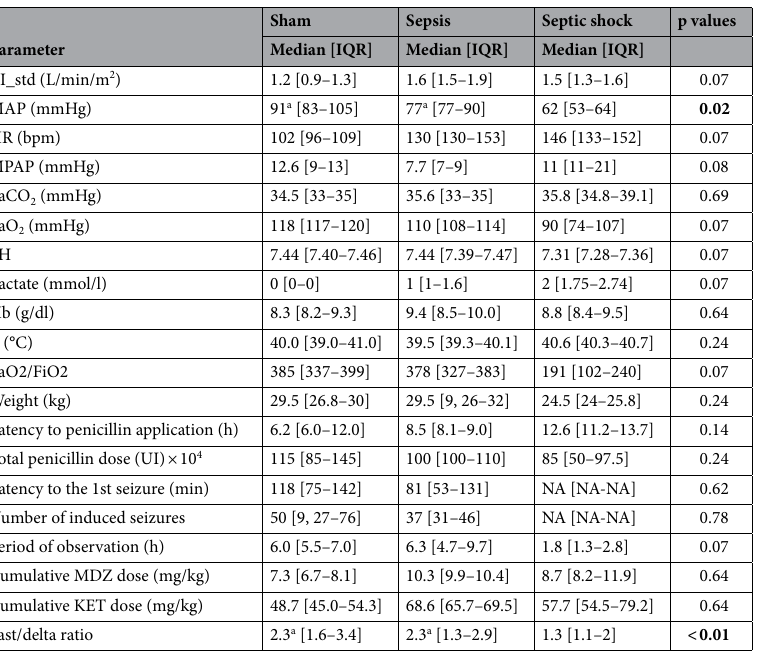
Table 1. Summary of systemic, biological parameters and information at time of penicillin application in the studied animals. Data are presented as median and (IQR). CI_std: cardiac index standardized, expressed as variation of the cardiac index of the beginning of the experiment; MAP: mean arterial pressure; HR: heart rate; MPAP, mean pulmonary arterial pressure; Hb: hemoglobin; T °C: temperature in Celsius degrees; PaO 2 / FiO 2 : ratio used to identify and quantify acute lung injury (acute lung injury if ratio ≤ 300, acute respiratory distress syndrome if ratio ≤ 200). MDZ: midazolam; KET: ketamine; NA, not applicable. Fast-delta ratio of the ECOG signal was calculated before penicillin application. Variables were analyzed using the Kruskal– Wallis test. P-values were corrected for false discovery rate; the Dunn’s post hoc tests are presented in case of q-values < 0.05 (in bold in the table). a significant at 5% vs. septic